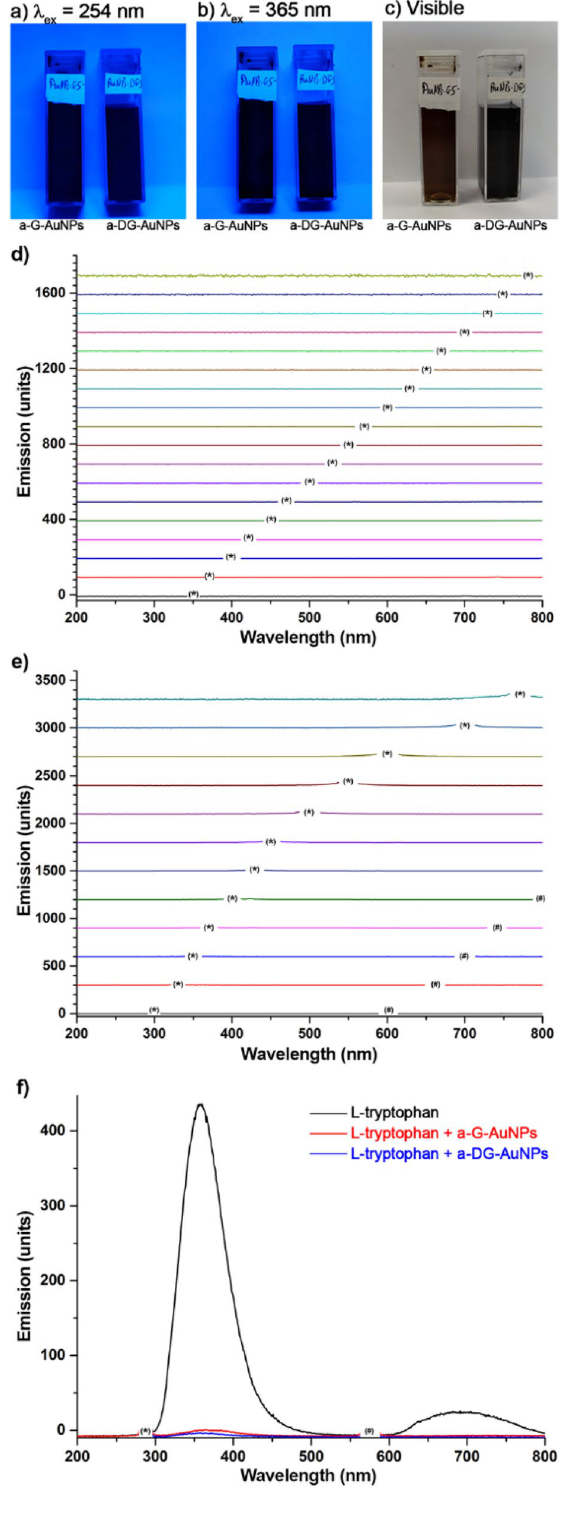
Figure 3. Aqueous suspensions of a-G-AuNPs and a-DG-AuNPs (700 μg/mL) under UV ( a , b ) and visible light ( c ) irradiation. Emission spectra of a-G-AuNPs ( d ) and a-DG-AuNPs ( e ) at variable wavelengths of excitation. Emission spectra with excitation at 287 nm ( f ) of l-tryptophan (1.5 × 10 –5 mol/L) in absence and in presence of a-G-AuNPs or a-DG-AuNPs (125 µg/mL). * λ ex ; # Diffraction at 2λ ex due to diffraction from the grating of the spectrometer